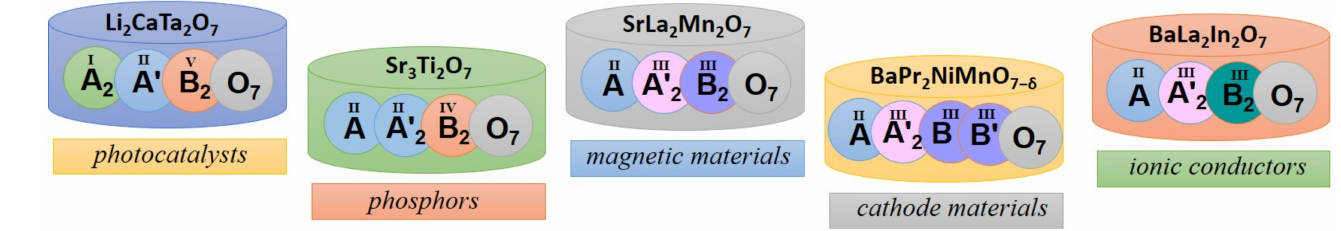
Figure 1. The overview of materials with a double-layered Ruddlesden–Popper